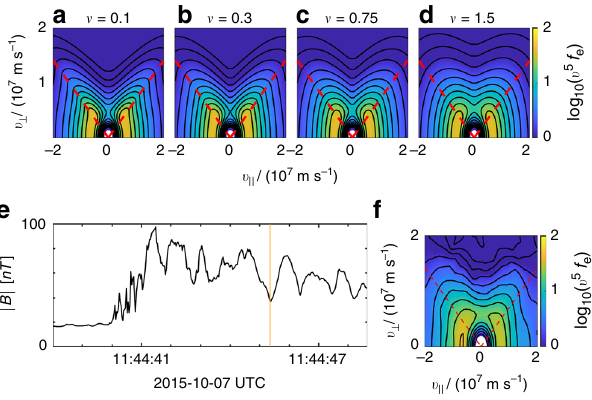
Fig. 6 Estimating the effective scattering frequency. a – d Electron distribution functions computed using Eq. (3) integrated at ð δ B = B 0 Þ sin ð ω t 0 Þ ¼ 0 : 5 for a range of scattering frequencies. e Plot of the magnetic fi eld for the relevant bow shock crossing. f MMS3 observation of an electron distribution function at the orange line in e , where we estimate ~ B ¼ 0 : 5.